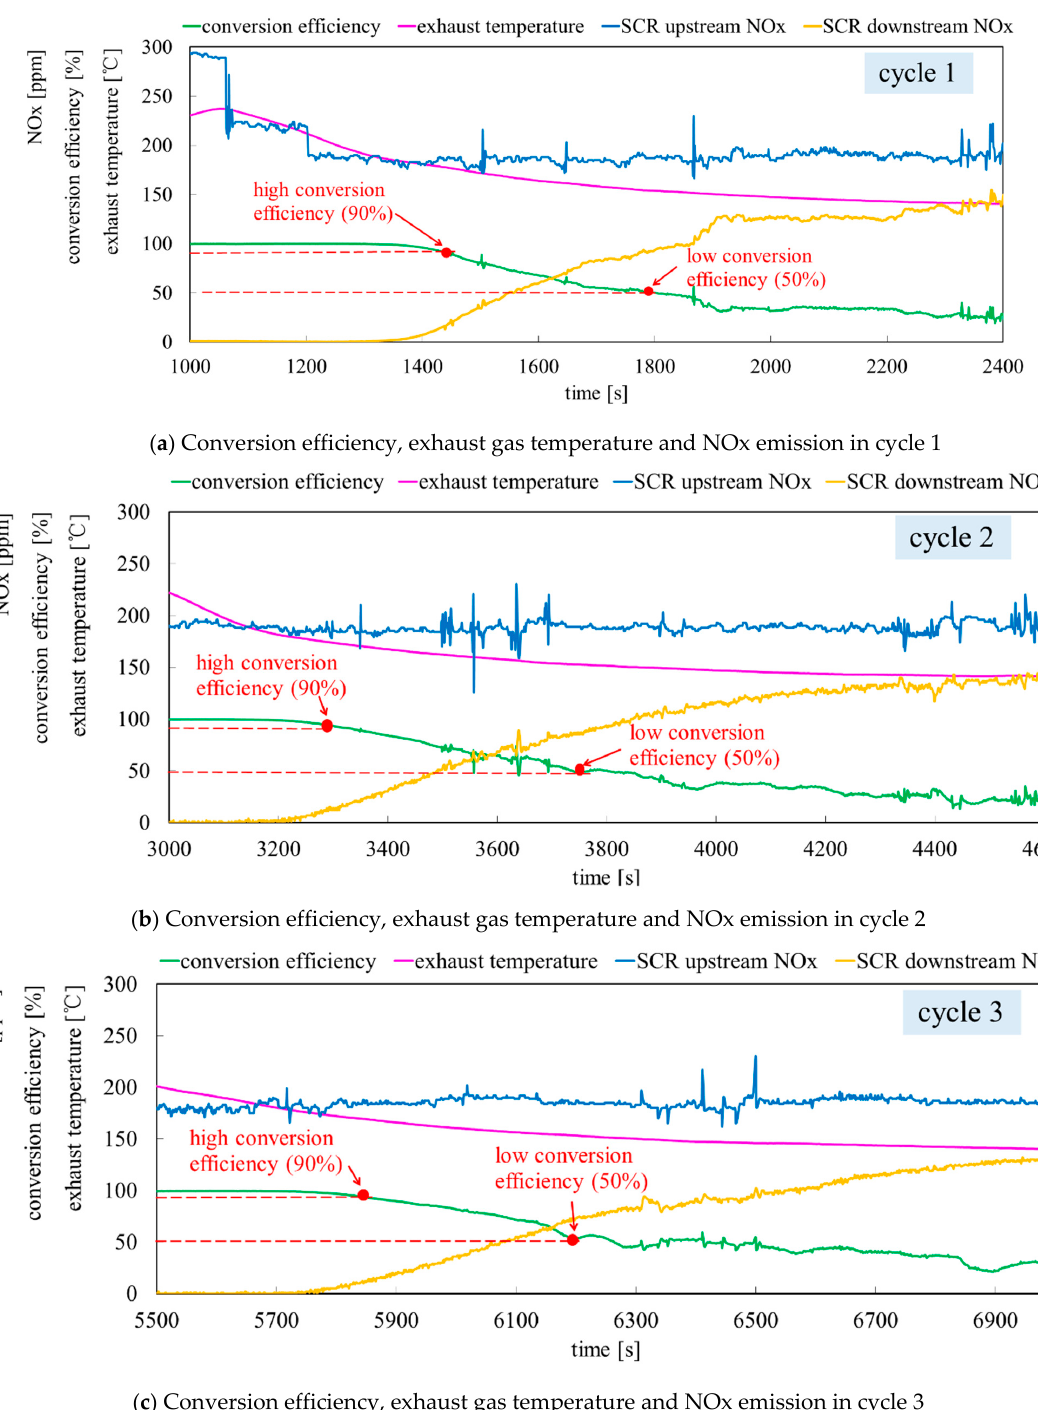
Figure 5. Test results for SCR state II.